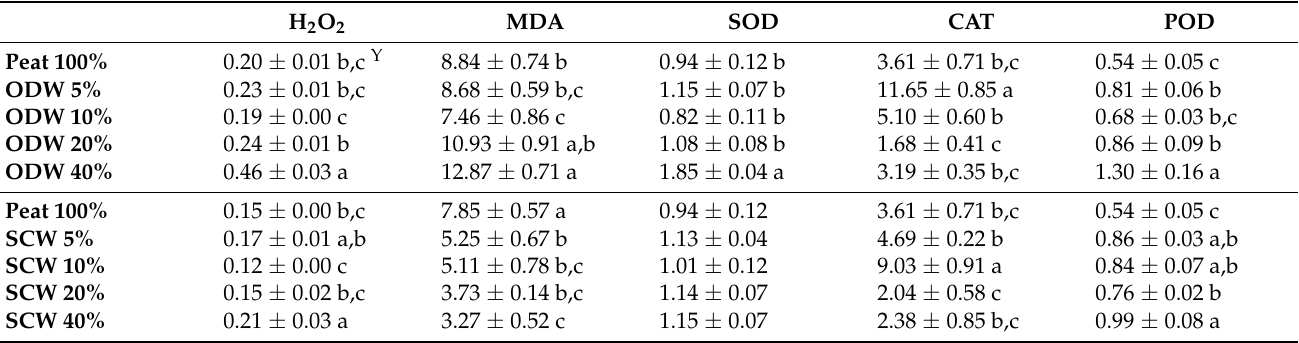
Table 6. Impact of growing media (peat, Origanum dubium waste—ODW, Sideritis cypria waste— SCW) on hydrogen peroxide (H 2 O 2 ) ( µ mol/g), lipid peroxidation (MDA) (nmol/g), and antioxidant enzyme activity of superoxide dismutase (SOD; units/mg protein), catalase (CAT; units/mg protein), and peroxidase (POD; units/mg protein) of purslane plants. H 2 O 2 MDA SOD CAT